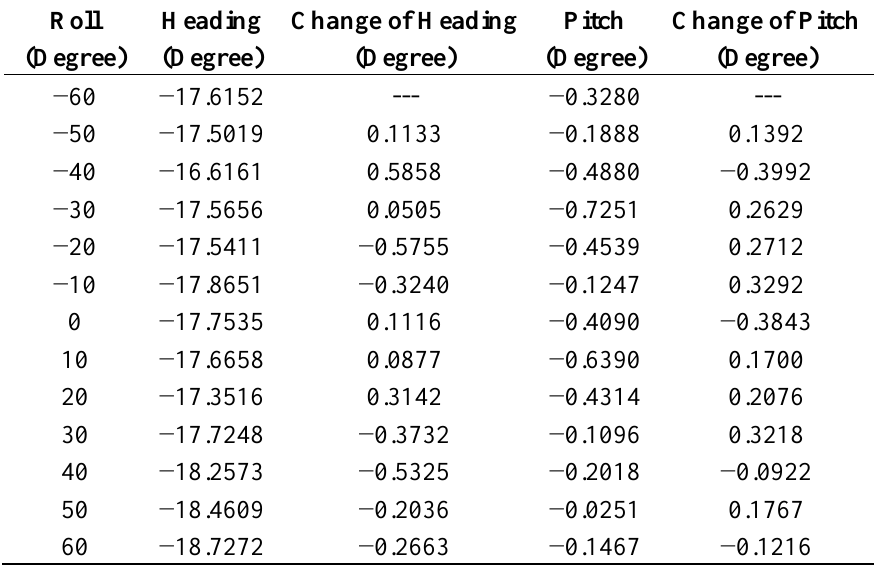
Table 8. The outputs of heading and pitch while roll is changing (using backing